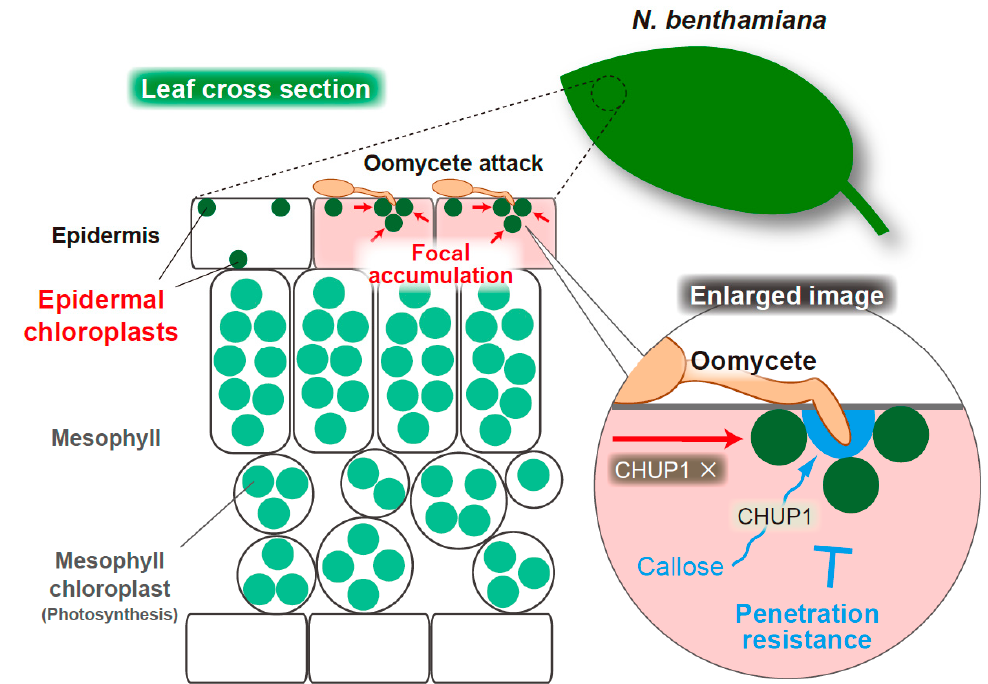
Figure 5. Schematic overview of the focal accumulation of the epidermal chloroplasts and callose deposition at the penetration site of oomycete P. infestans in epidermis of N. benthamiana . A hyphal entry of P. infestans triggers the intracellular movements of epidermal chloroplasts to the interfaces in a CHUP1-independent manner, while CHUP1-dependent callose deposition occurs at the penetration site of the pathogen and might contribute to penetration